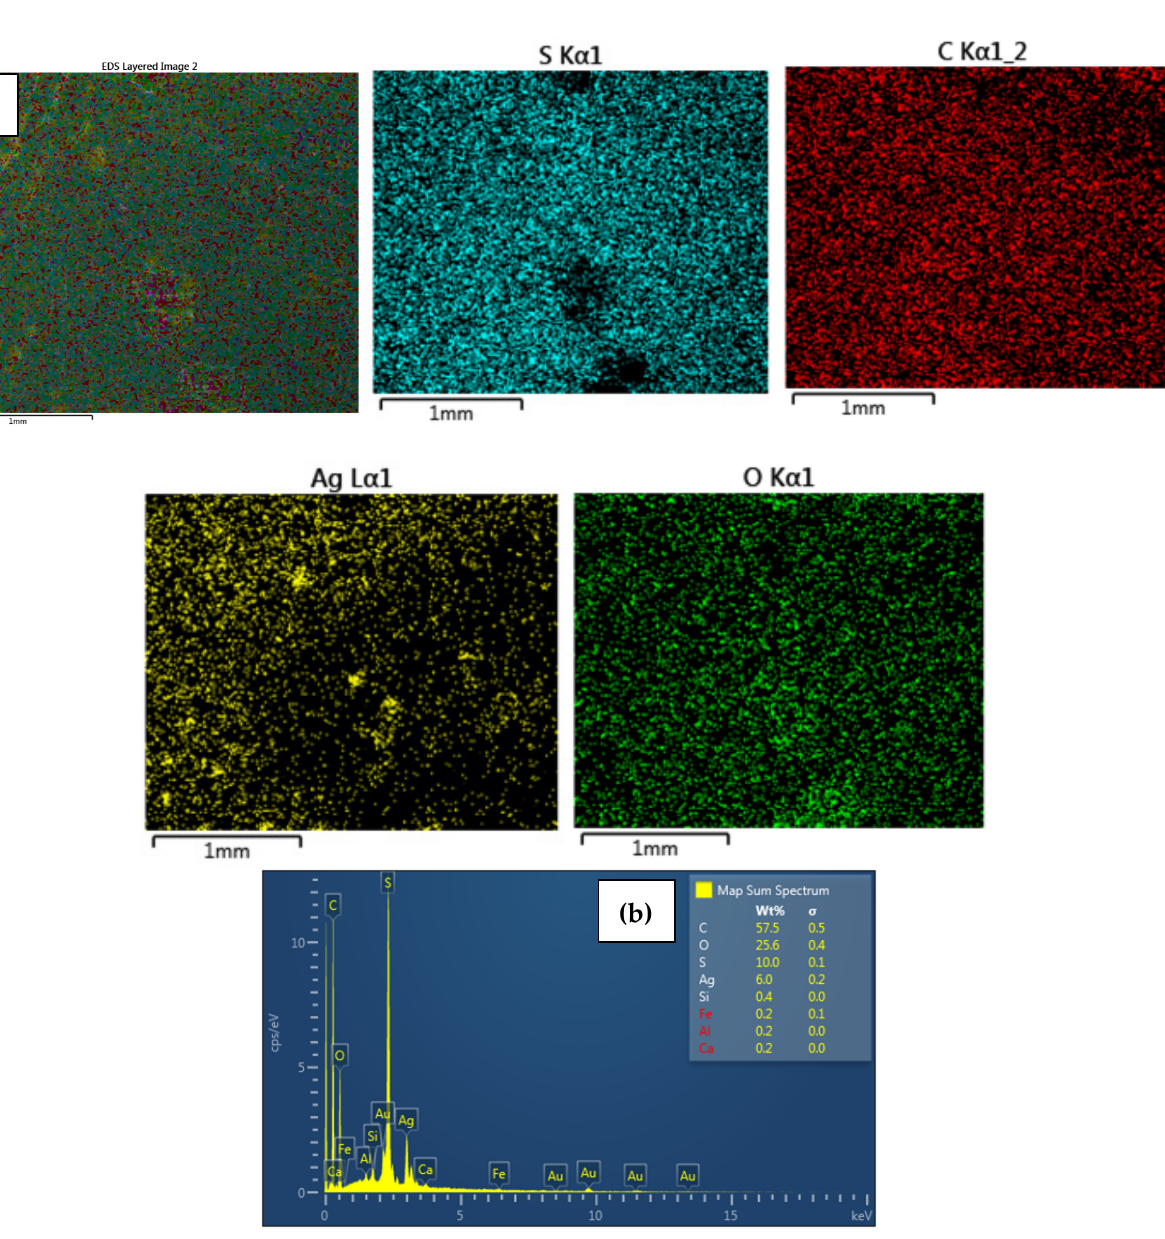
Figure 5. Elemental maps showing the composition of the analyzed AEM membrane surface; ( a ) combined elemental mapping of C, S, O and Ag and ( b ) EDS spectra confirming the presence of AgNPs of AEM-Ag3 nanocomposite membrane.